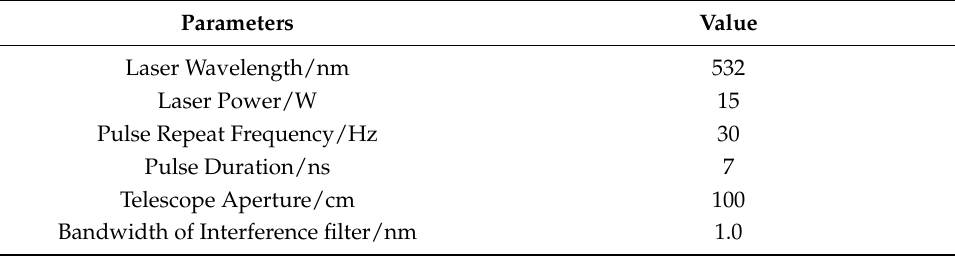
Table 1. Main parameters of the Rayleigh